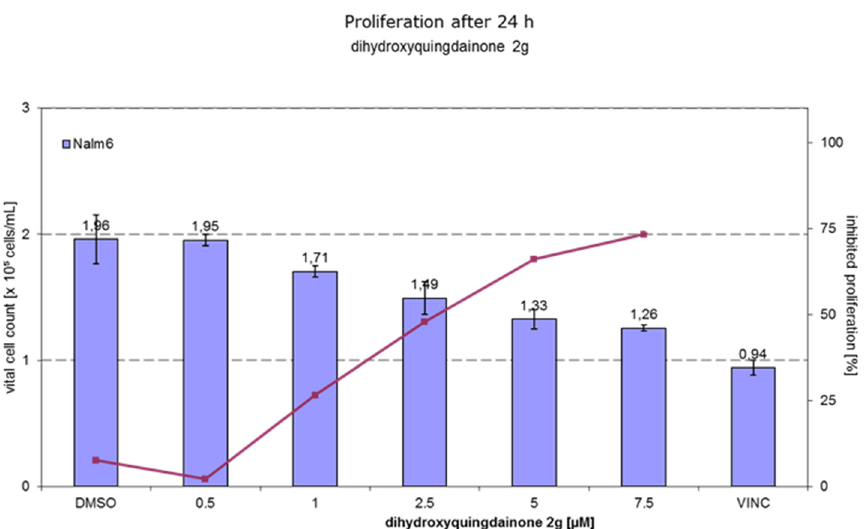
Figure 4. Anti-proliferative effects of 2g in 1 × 10 5 Nalm-6 cells/mL after treatment for 24 h. The number of Nalm-6 cells was determined by CASY ® Cell Counter after 24 h of incubation with different concentrations of 2g . Three replicates were carried out per concentration. The mean values ± SD are shown ( p < 0.05 vs. DMSO, t -test). The DMSO control without 2g shows a cell proliferation from 1 × 10 5 Nalm-6 cells/mL up to 1.96 × 10 5 Nalm-6 cells/mL. Dihydroxyquingdainone 2g inhibits the proliferation of leukaemia cells in a dose-dependent manner. Vincristine (VINC) is the positive control (no cell proliferation after 24 h—100% inhibition of proliferation after treatment with 22.7 nM vincristine for 24